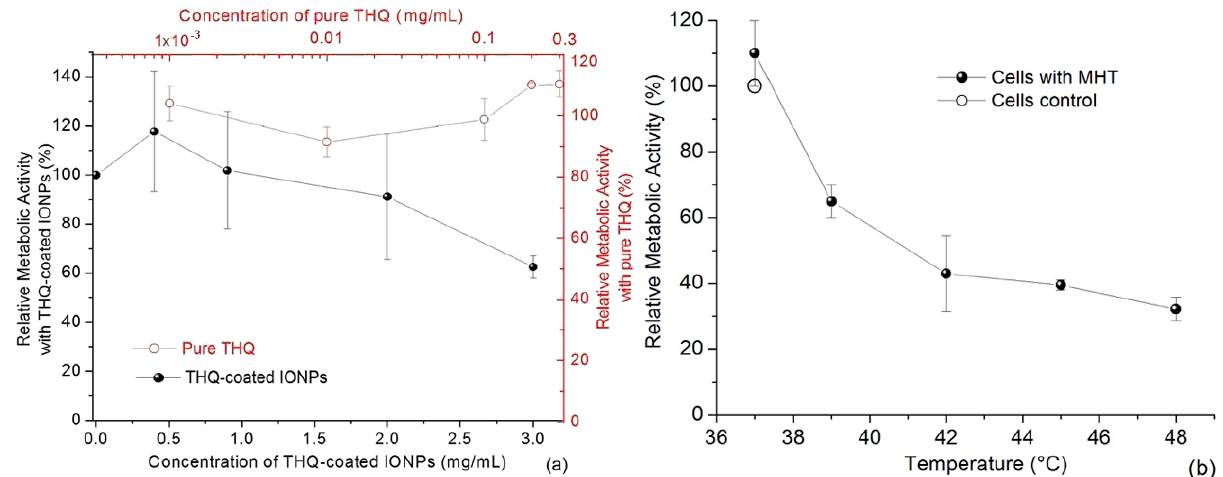
Figure 7. Relative metabolic activity of HT-29 cells ( a ) exposed to different concentrations of THQ-coated IONPs (black axis and dots) and pure THQ (red axis and open dots), respectively, ( b ) and HT-29 cells with 2 mg/mL of THQ-coated IONPs treated for 15 min with MHT and reaching different temperatures. Error bars indicate SD.